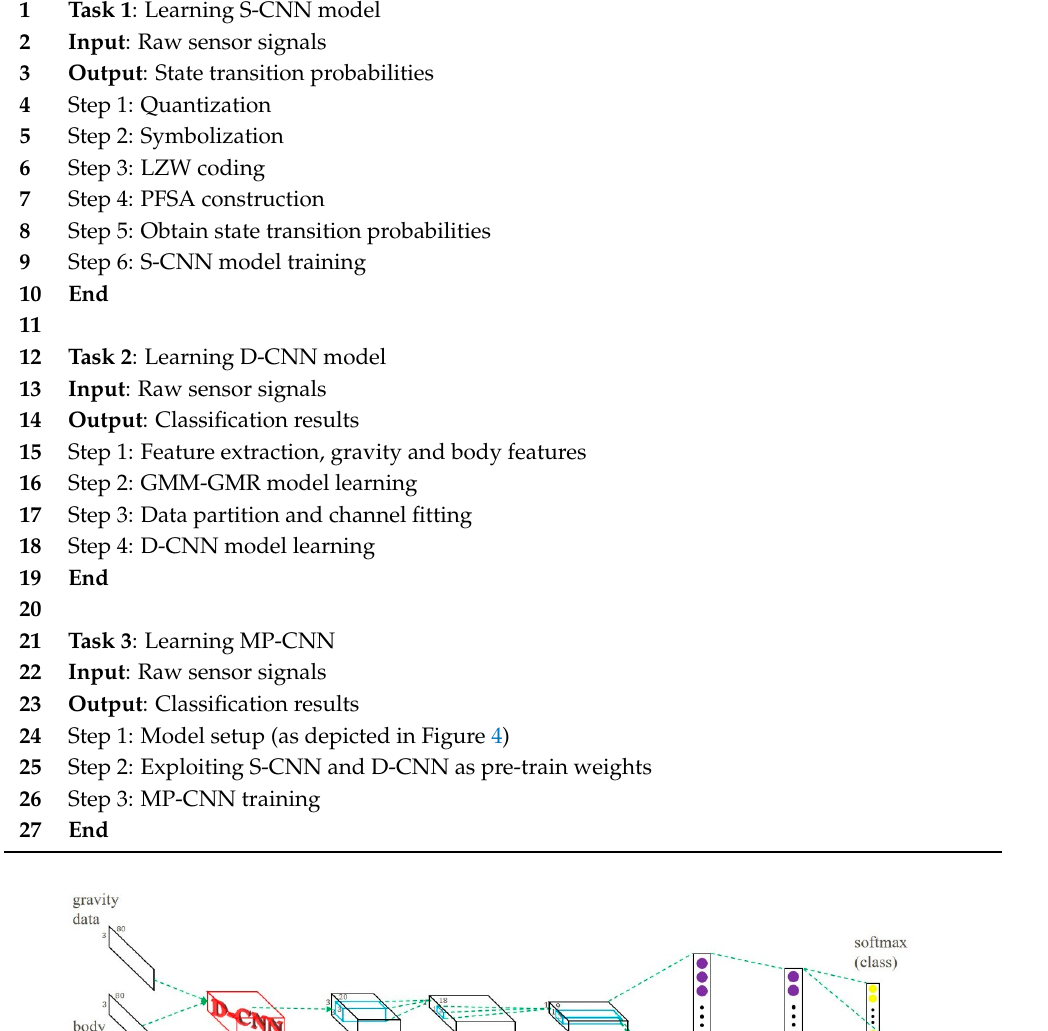
Algorithm 2: Multipath Convolutional Neural Network